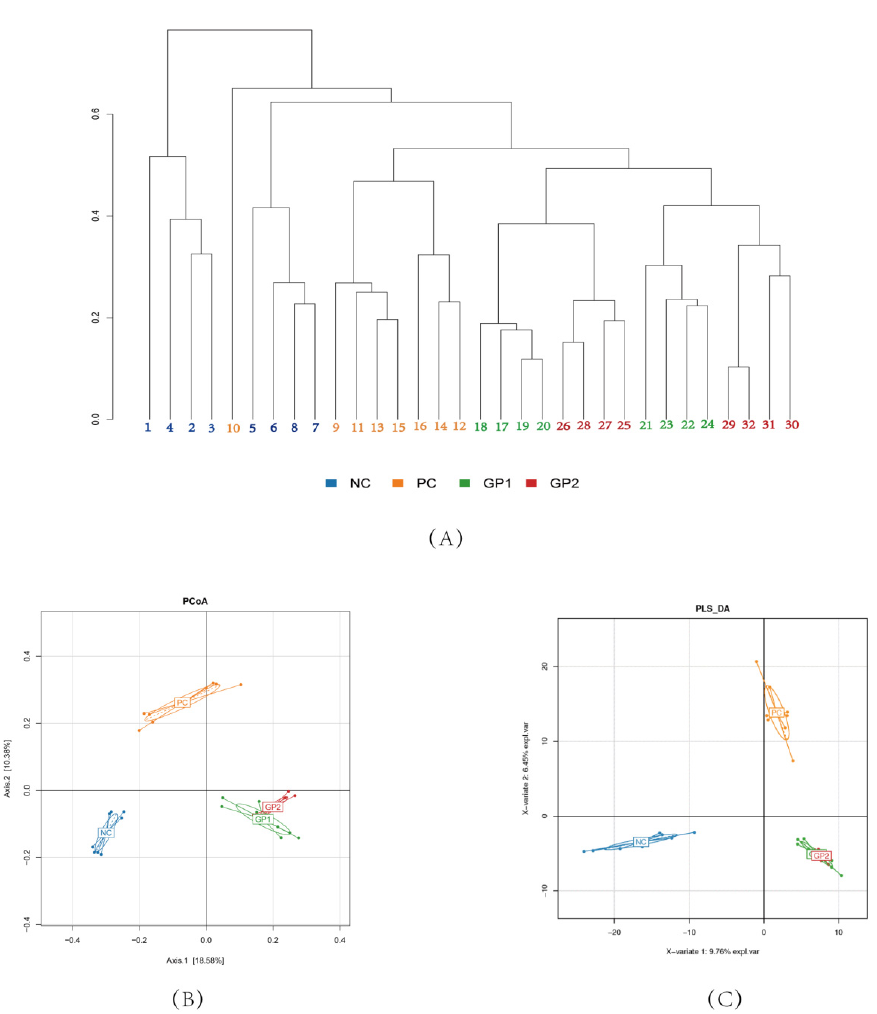
Figure 8. Effects of GP on microbial profiles based on OTU abundance. ( A ) Samples cluster tree; ( B ) PCA; ( C ) PLS.